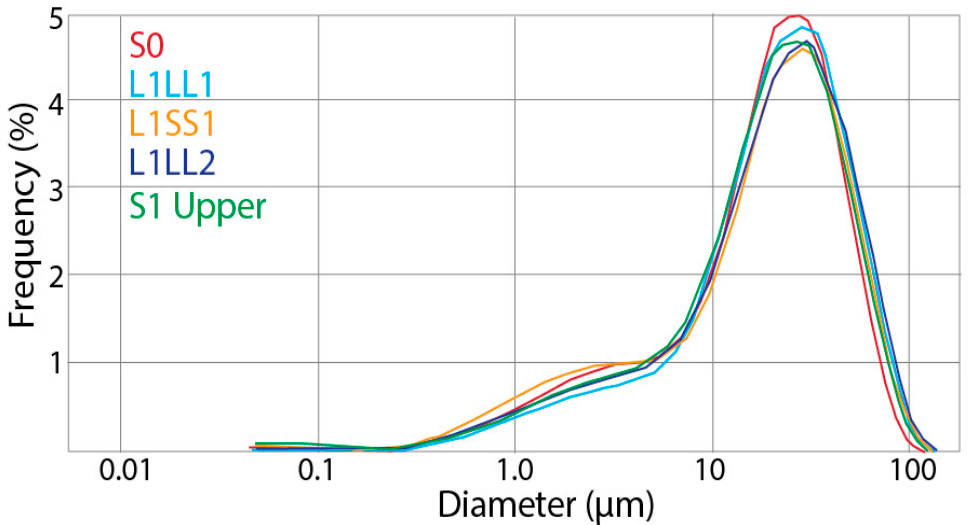
Figure 5. The frequency distributions of samples from S0, L1LL1, L1S1, L1LL2, and S1 of the Novo Orahovo loess section.